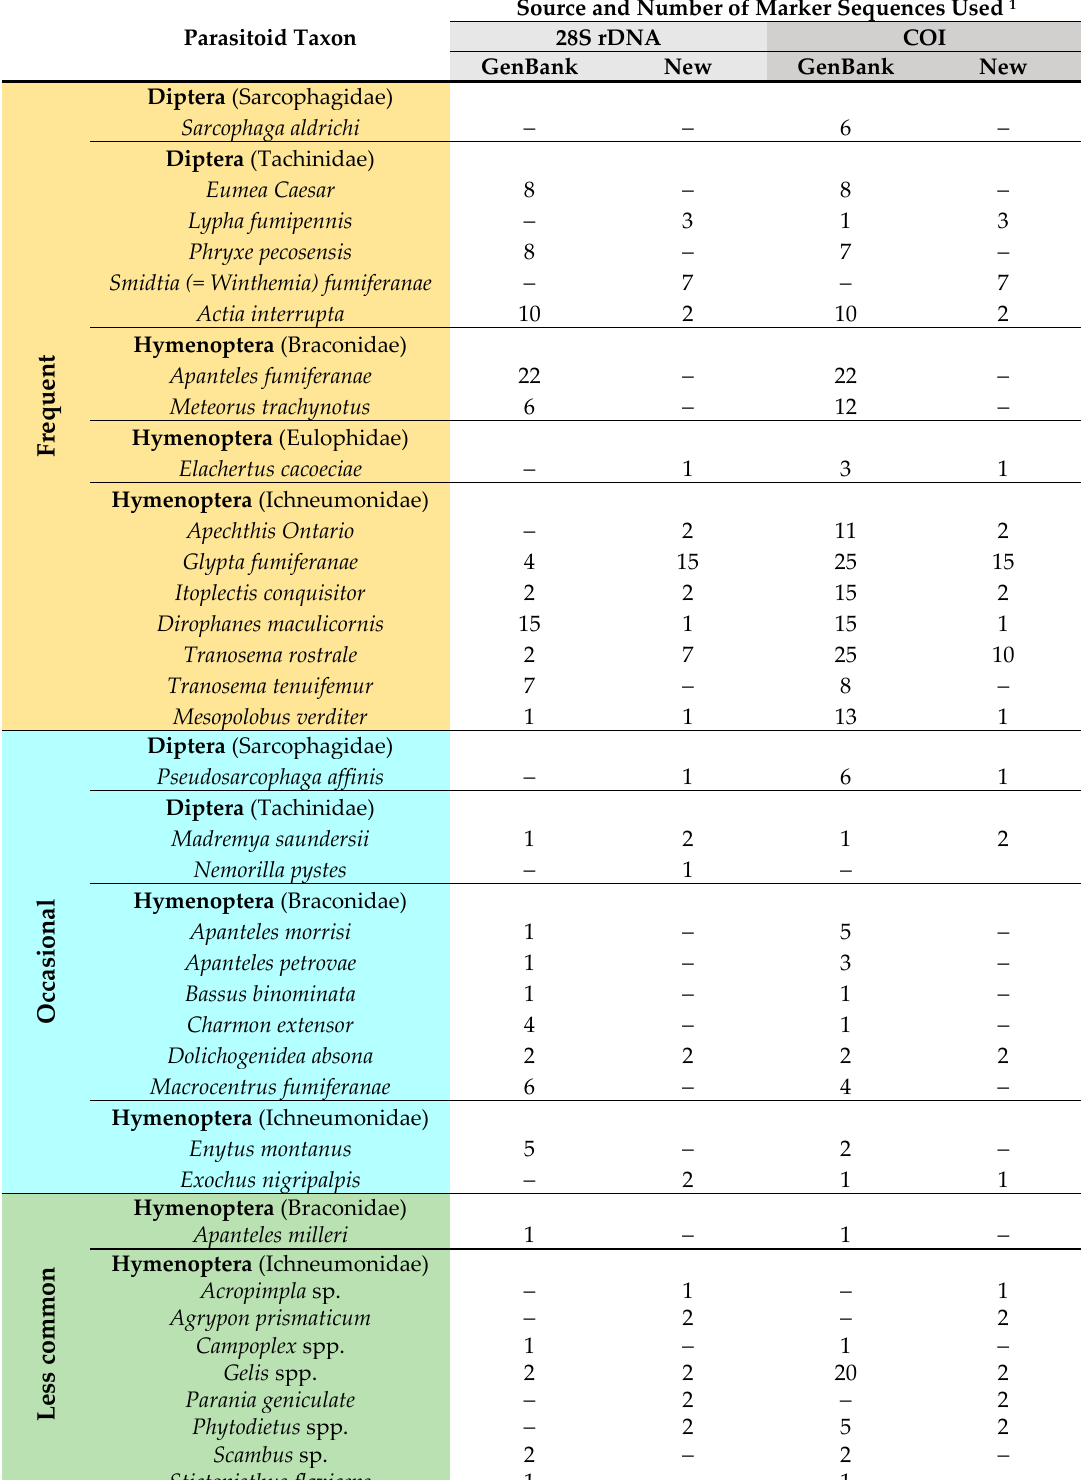
Table 1. Source [GenBank or “New” (i.e., this work)] and number of 28S rDNA and COI barcode sequences (haplotypes) populating the parasitoid marker database that was used for developing the molecular sorting